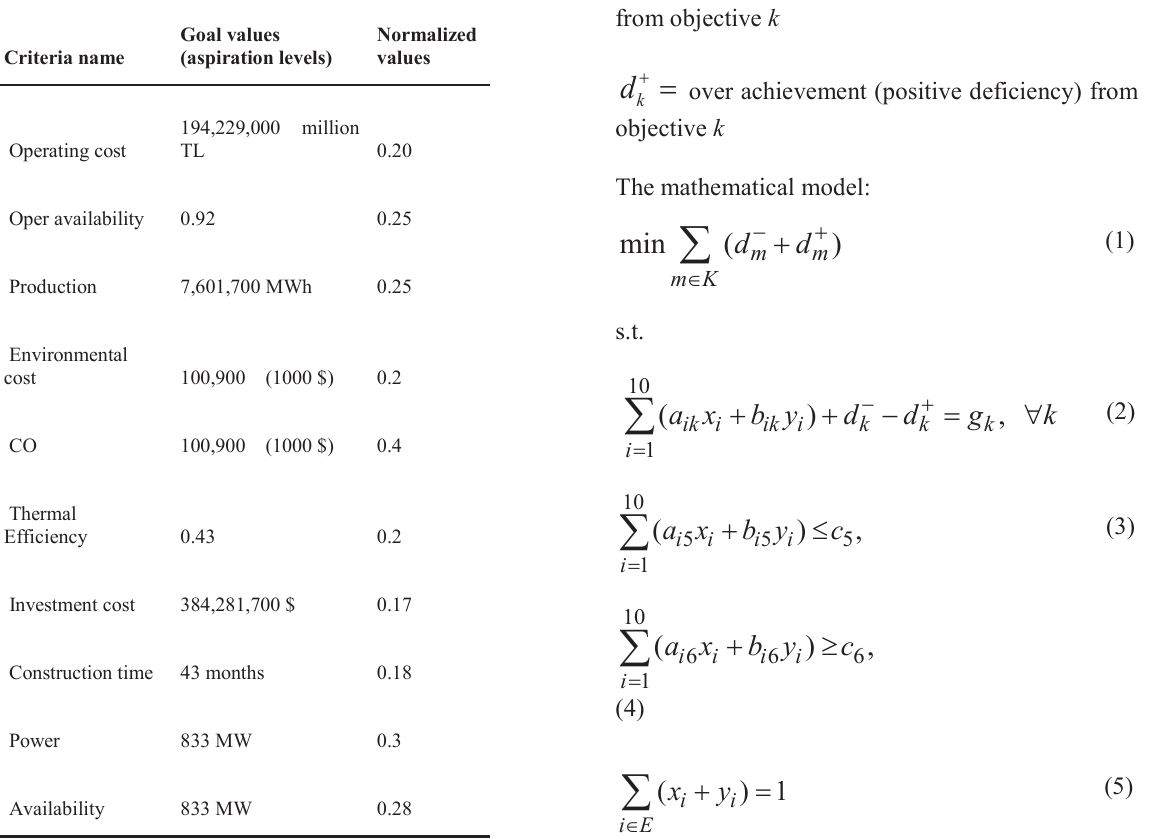
Table 6. Aspiration levels of